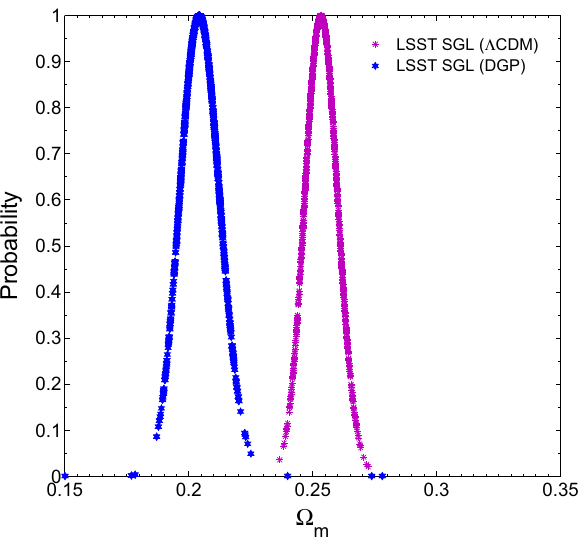
Fig. 4 Scatter plot of 10,000 simulated strong lensing systems from future LSST surveys Fig. 5 Constraints on the cosmological parameters from the simulated LSST strong lensing